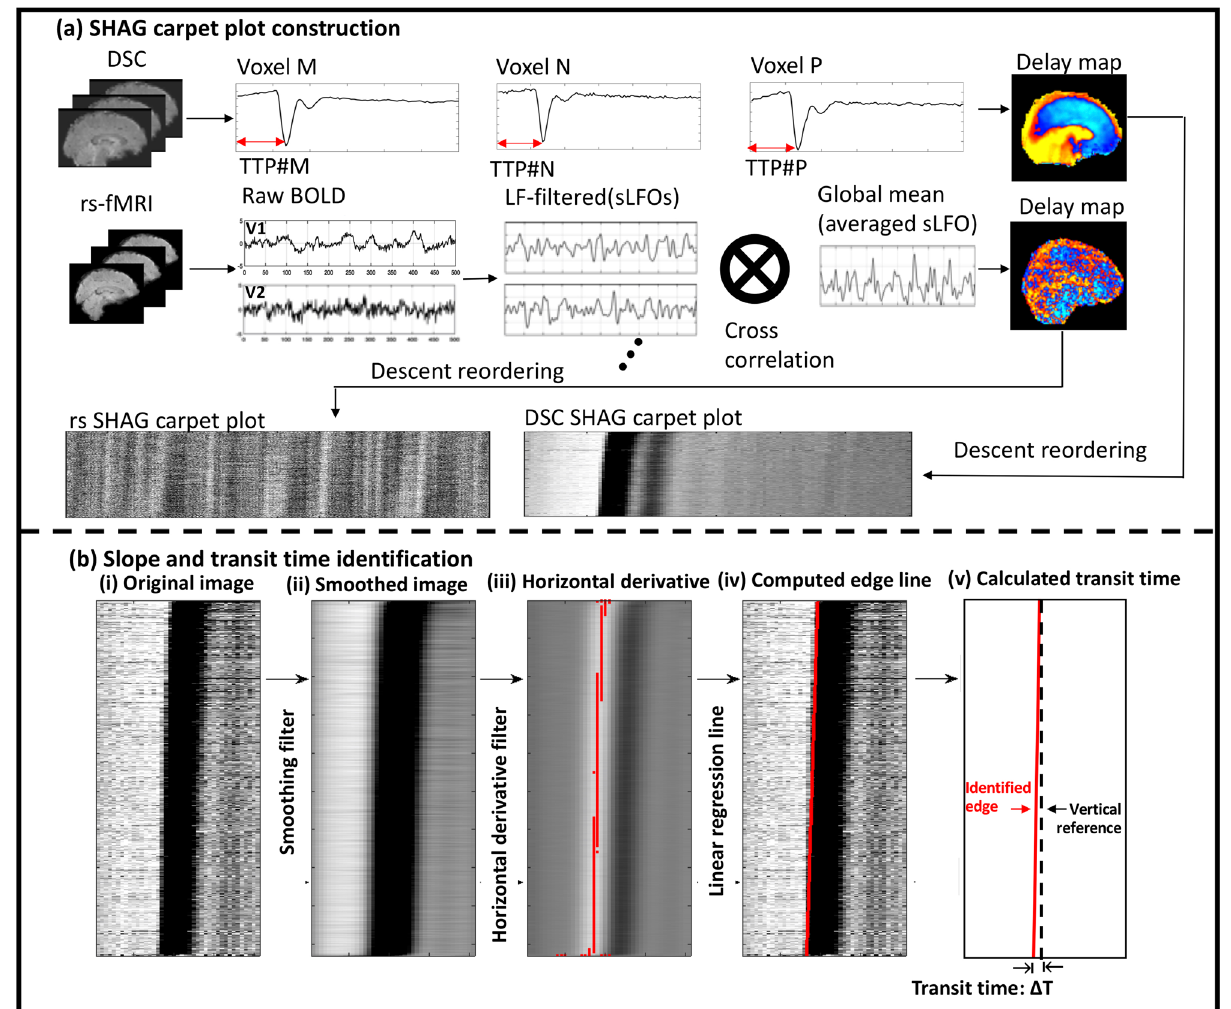
Figure 1. Demonstration of carpet plot reconstruction and slope identification. ( a ) Carpet plot reconstruction for DSC-MRI and for rs-fMRI. Carpet plots for DSC-MRI scans were constructed by reordering voxels in descending order based on time to peak (TTP). Carpet plots for rs-fMRI were reconstructed by reordering voxels based on the delay time derived from the cross-correlation between the sLFO signal for a given voxel and the averaged global sLFO across all voxels in the brain. MRI data processing and image visualization was assisted by use of the FMRIB Software Library (FSL, v5.0 for DSC and rs-fMRI data, v6.0 for the CO 2 -MRI data, https:// fsl. fmrib. ox. ac. uk/ fsl/ fslwi ki) 24 . ( b ) Slope-detecting algorithm developed for computation of carpet plot edge slopes and transit times. The original image (i) is smoothed with a 2D blurring filter (ii), followed by a horizontal derivative filter (iii). For every row of (iii), the maximum derivative location is located and denoted by a red point. These points are used as data to compute a linear regression line or edge, shown in (iv), from which the slope (steepness of the edge) and the transit time (time difference between the bottom and top of an identified edge indicating the time taken for the corresponding fluctuation to traverse all voxels in the carpet plot) can be were not concentrated in any particular brain region but appeared in regions of white matter (WM), gray matter (GM), and cerebrospinal fluid (CSF). This is illustrated in Fig. 2, column (c) as a segmented version, in which the voxels of the carpet plot were divided into the three tissue classes with voxel ordering based on corresponding delay times as in column (b). A strong motion artifact was present in the rs-fMRI data for the subject displayed in Fig. 2. This artifact (indicated by a yellow arrow) affects all the voxels instantaneously, leading to a vertical line in the carpet plot regardless of the ordering method. Hereafter, all analysis was conducted on the novel method to reorder the carpet plots (column (b) in Fig. 2) with noisy voxels cropped out (as displayed in Figs. 3, 4, and 5). Comparing the DSC-MRI and rs-fMRI data transit times. An in-house slope-detection algorithm (see Fig. 1b) was used to detect edges present in each SHAG carpet plot and compute each edge’s transit time. For DSC carpet plots, a single edge was computed which corresponds to the arrival of the gadolinium contrast